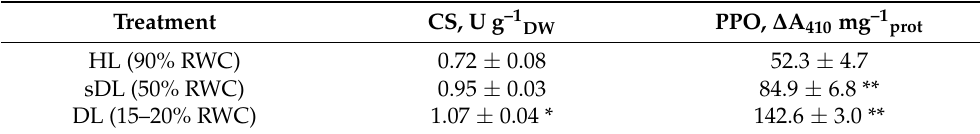
Table 2. The endogenous citrate synthase (CS) and polyphenol oxidase (PPO) in vitro activity during R. serbica desiccation. Values represent mean ± SE, n = 3–5. Asterisks denote significant differences between treatments and respective controls according to t -test (* p < 0.05; ** p > 0.01).